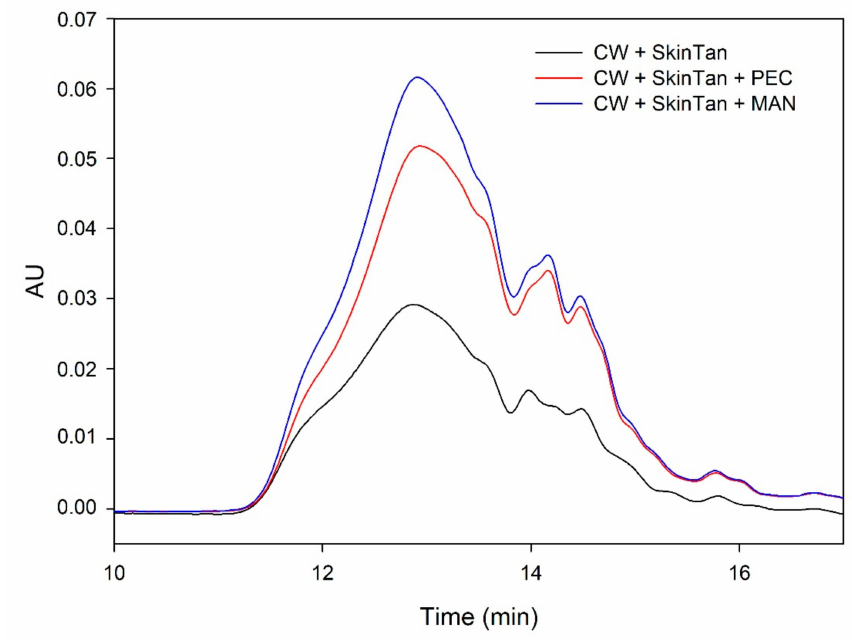
Figure 2. Analysis of the mass distribution of skin tannins in presence of CW by SEC. Comparison of the skin tannins in the absence (CW + SkinTan) and presence of PEC and